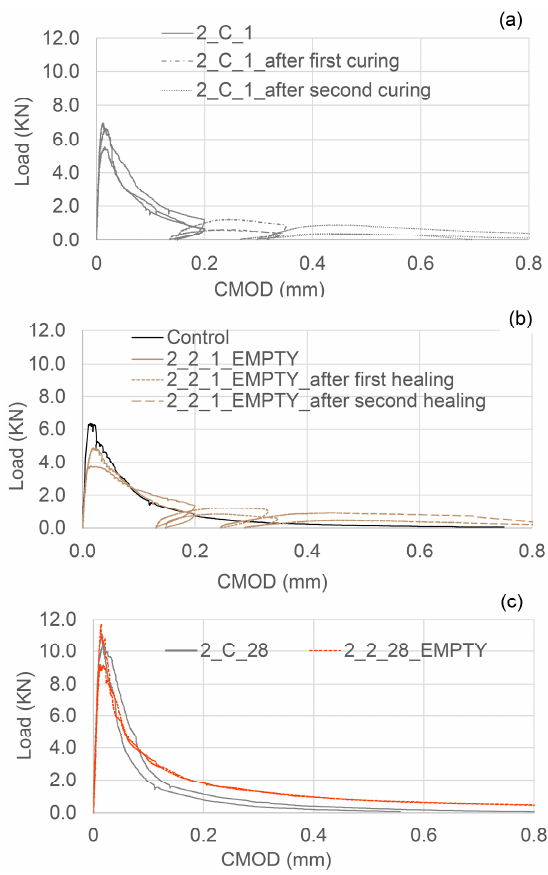
Figure 11. ( a ) Flexural load-CMOD response of control specimens; ( b ) Flexural load-CMOD response for 2 damage-healing cycles of specimens containing 2 empty TETs; ( c ) Flexural load-CMOD response at 28 days of specimens with and without empty TETs.